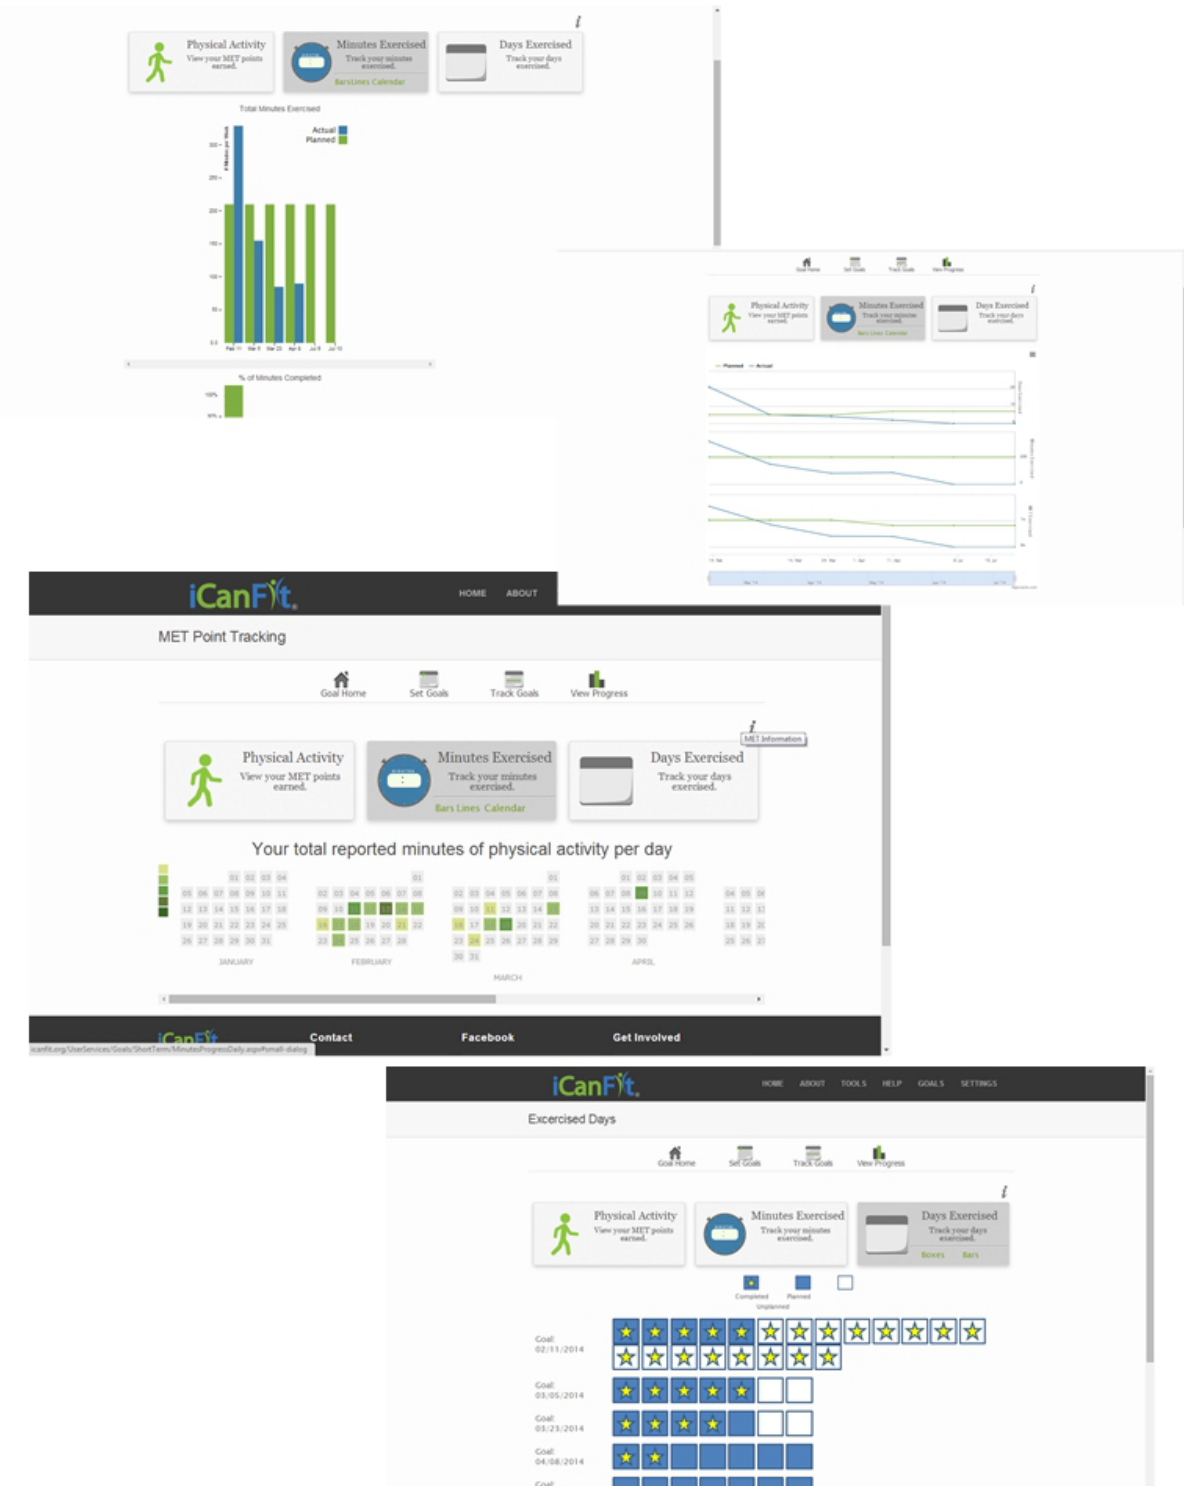
Figure 4. "View Progress" function of